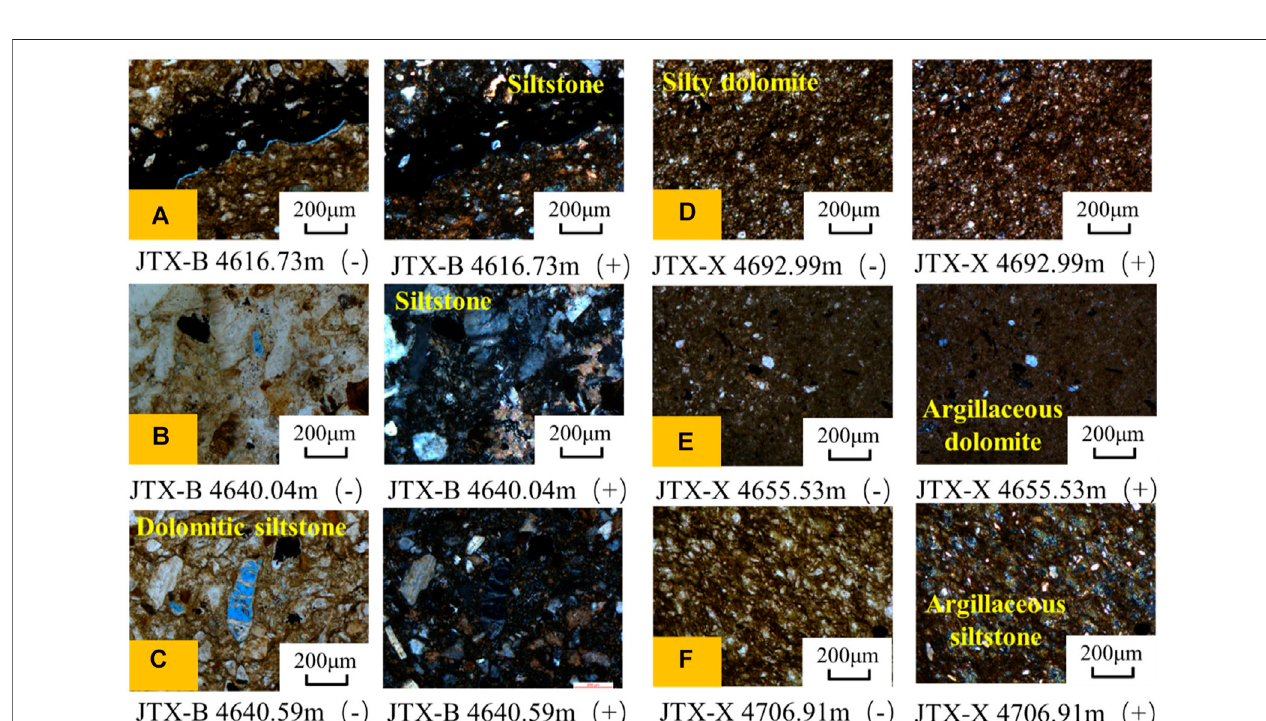
FIGURE 4 | Photomicrographs of reservoir rocks. (A) and (B) Siltstone; (C) Dolomite siltstone; (D) Silty dolomite; (E) Argillaceous dolomite; and (F) Argillaceous siltstone.